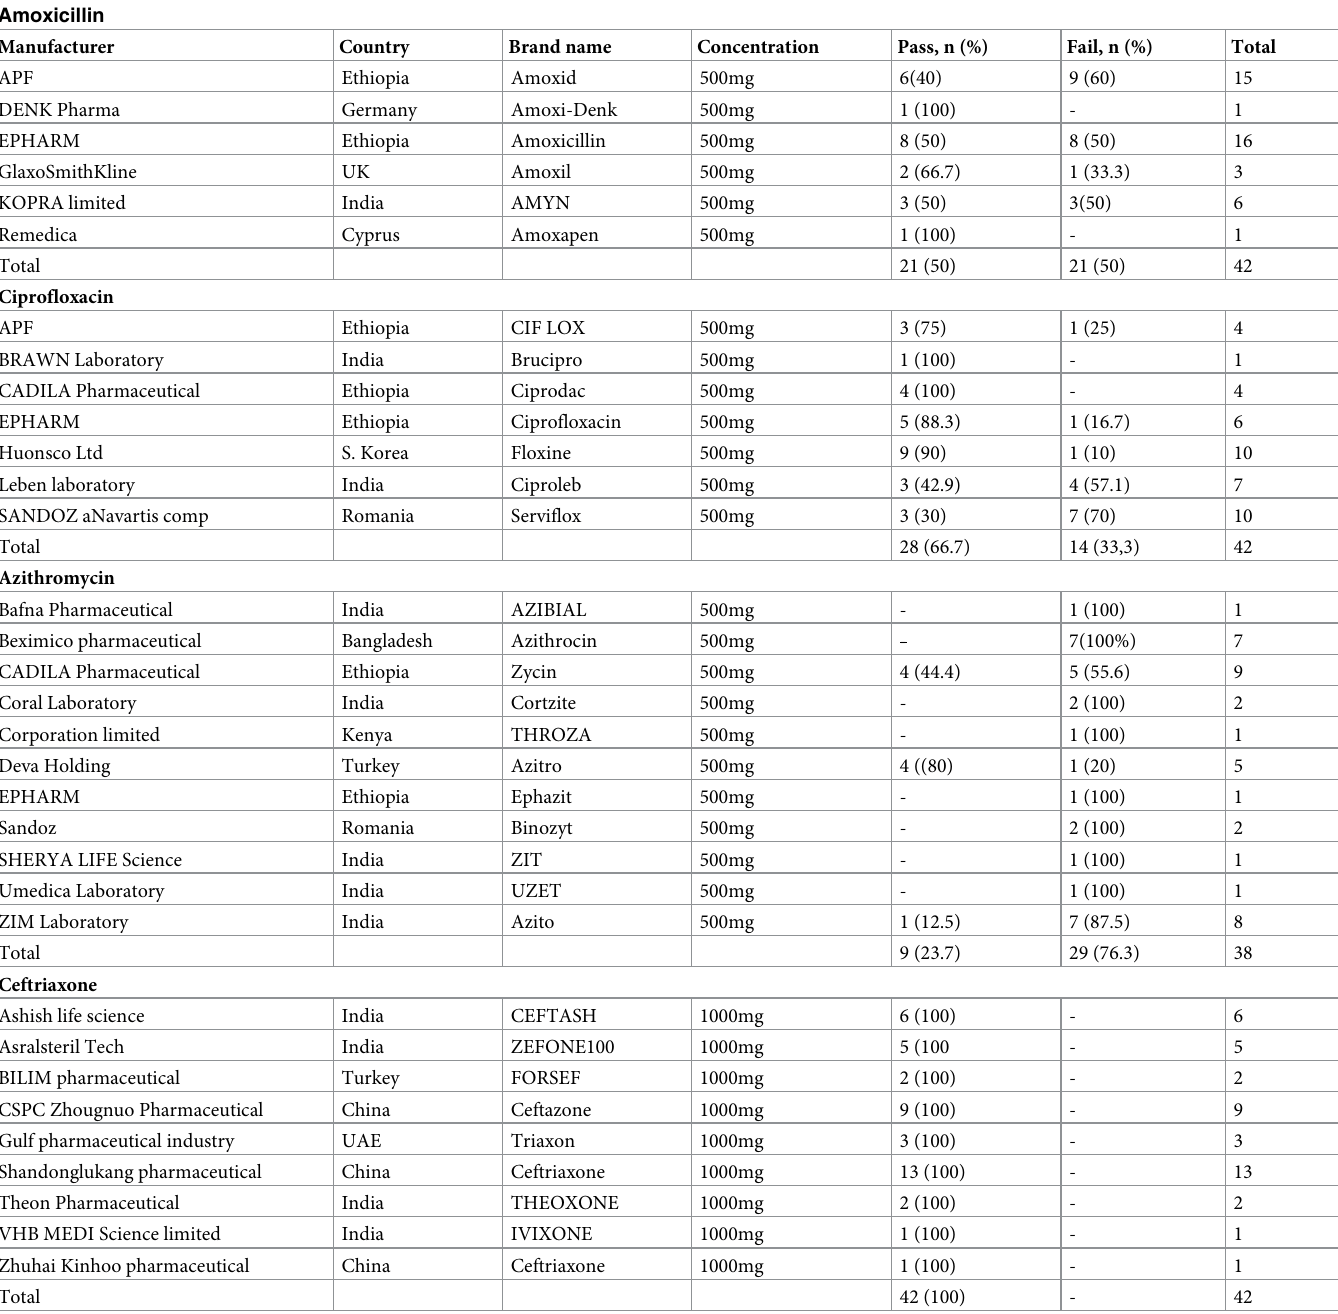
Table 5. Potency of selected antibiotics collected from pharmacies found in Adama, Ethiopia based on the manufacturer and country, March 2018 to June 2018.